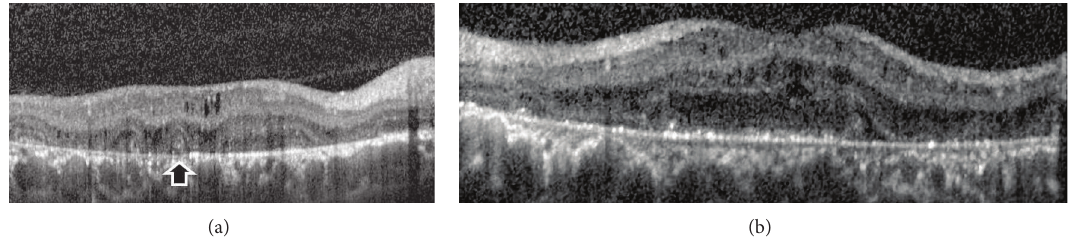
Figure 4: (a) SD-OCT of the right eye depicting the intraretinal cysts, outer segment tubulation (black arrow), and vitreomacular adhesion. (b) SD-OCT of the left eye demonstrating the intraretinal cysts.